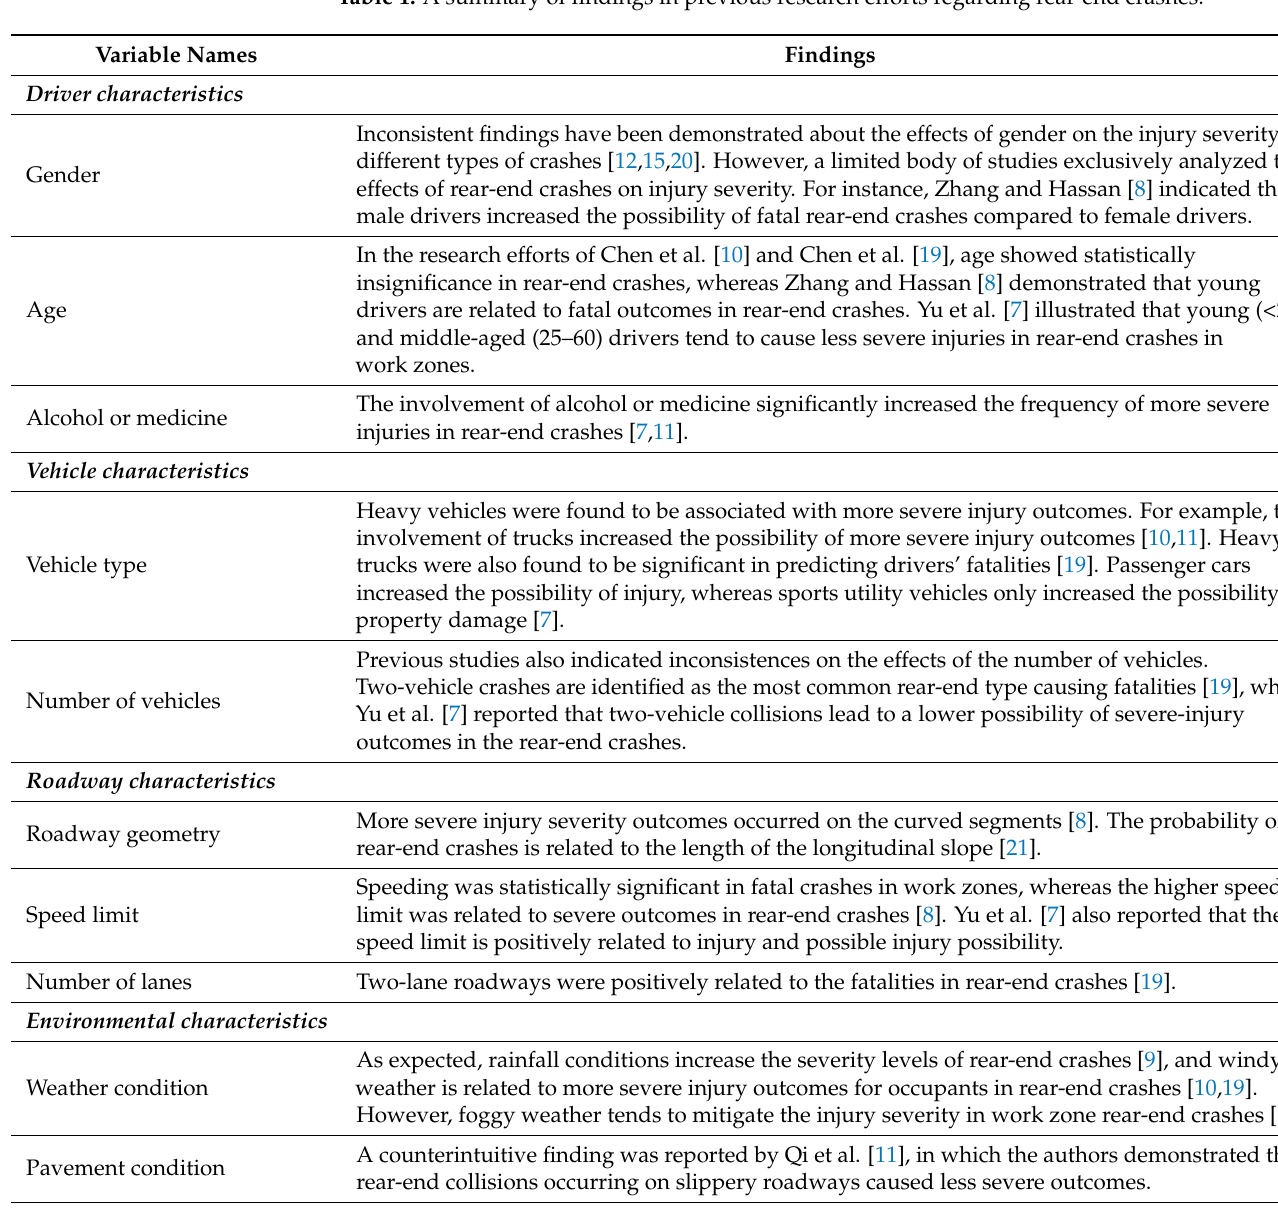
Table 1. A summary of findings in previous research efforts regarding rear-end